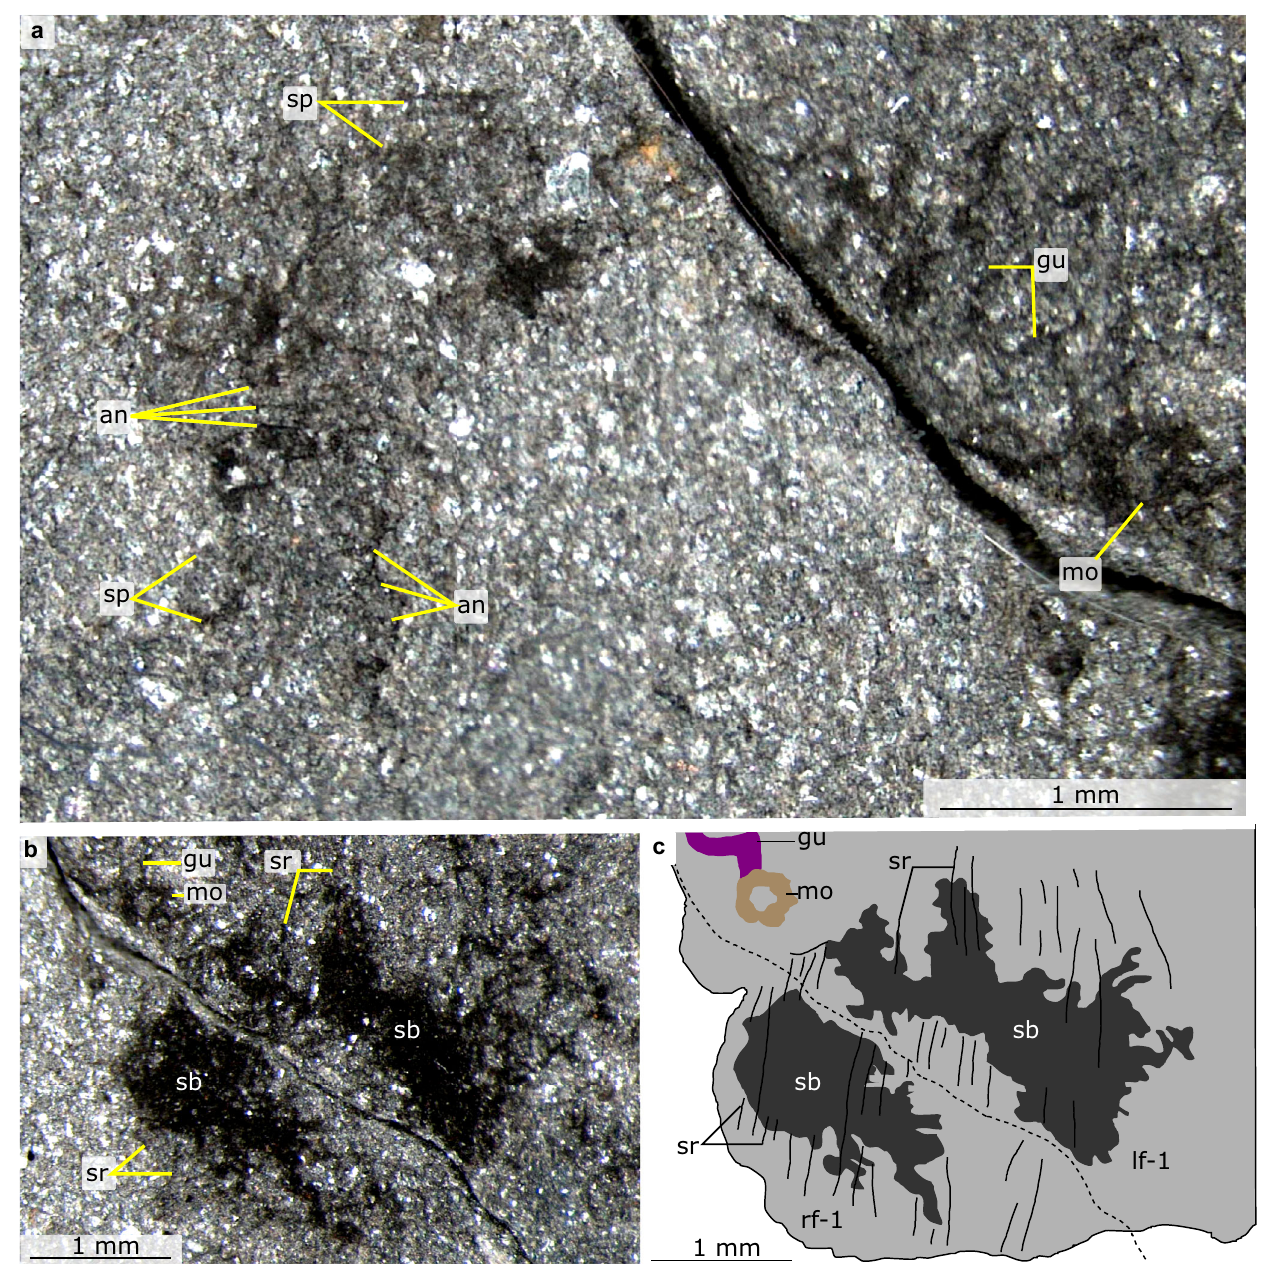
Fig. 2 | Details of anterior of Mieridduryn bonniae nov. gen. et sp. (NMW.2021.3G.7). a Anteriorof the headregionincluding proboscis, mouth, gut, view of anterior detailsincluding spinous proboscis, mouth and gut. b Mouth and